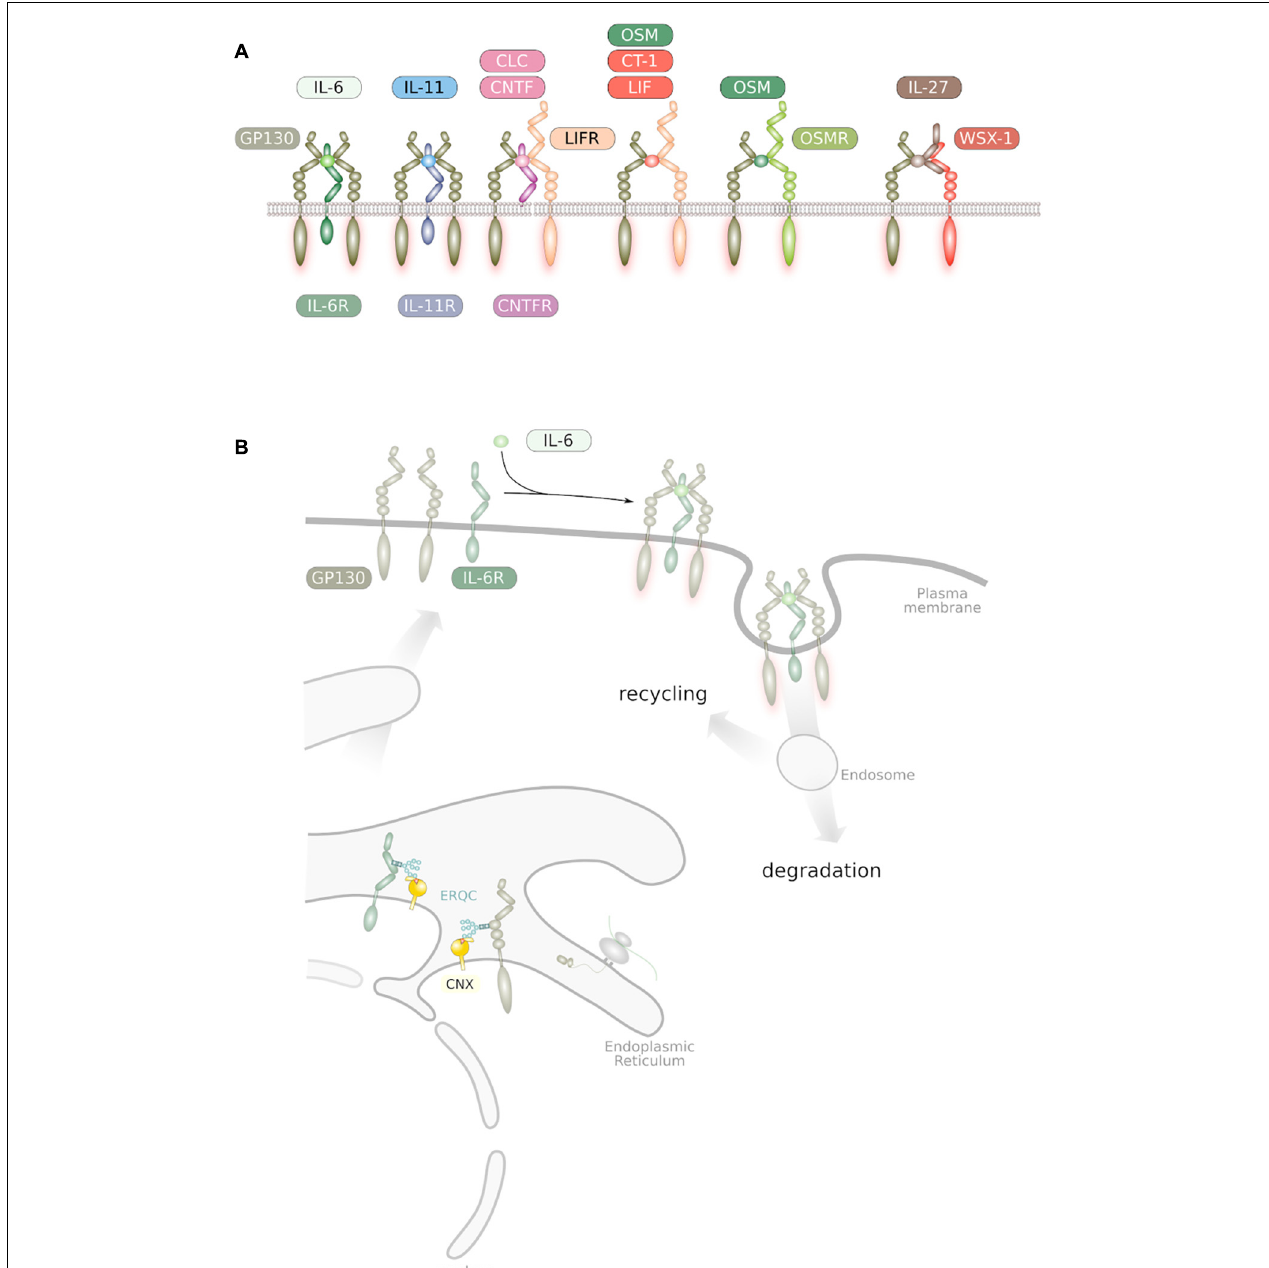
FIGURE 1 | (A) Overview of IL-6 family cytokine receptor complexes. GP130, LIFR, OSMR, and IL-27R α /WSX-1 are the only receptor subunits of the family that interact with members of the Janus kinase family and are therefore competent for signal transduction (Schmidt-Arras et al., 2021). (B) Trafficking of IL-6 family cytokine receptors. Receptors get synthesized into the endoplasmic reticulum and subsequently glycosylated at Asn residues. These glycans are essential during passage through the ER quality control. Ligand binding at the plasma membrane causes receptor homo/heterodimerization. Internalized receptors are either subjected to degradation or to recycling back to the plasma